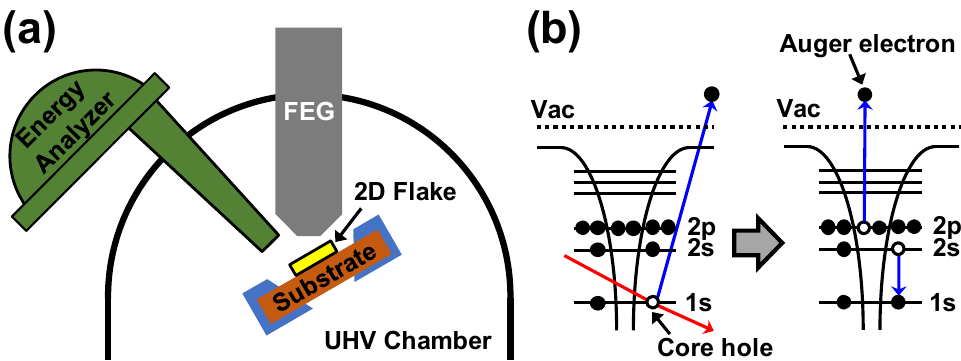
Figure 1. ( a ) Illustrative diagram of the nano-Auger electron spectroscopy (n-AES) system equipped with a field emission gun (FEG), a hemisphere energy analyzer, an ultra-high vacuum (UHV) chamber, a sample stage, etc. ( b ) Schematic views of the two-step Auger electron emission process. Vac indicates the vacuum level.